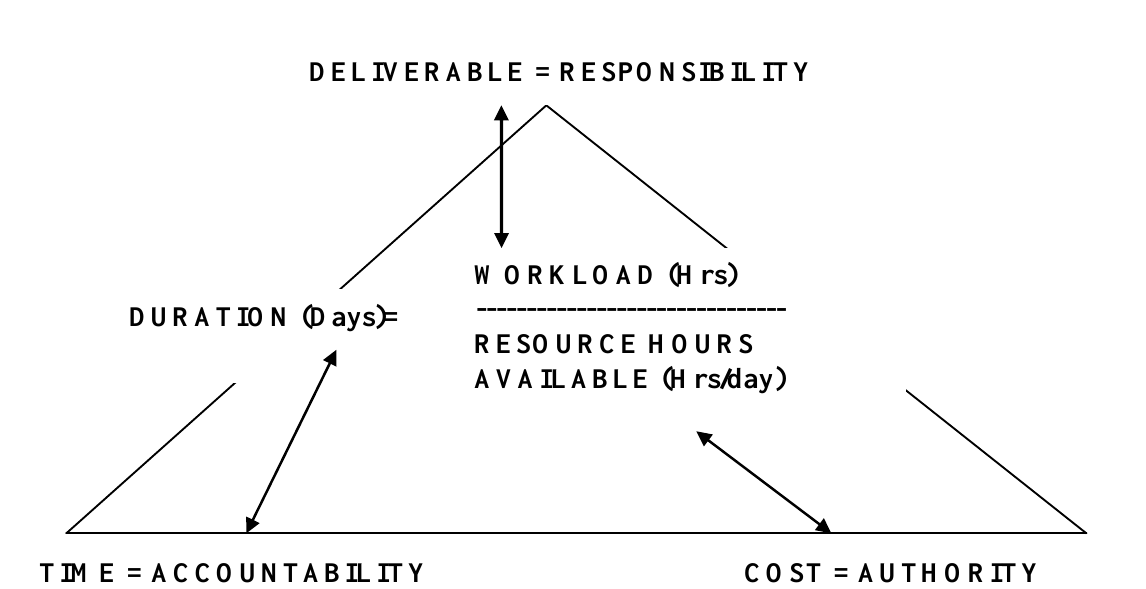
Figure 3: The golden triangle of management superimposed on the project triangle Source: Author’s own